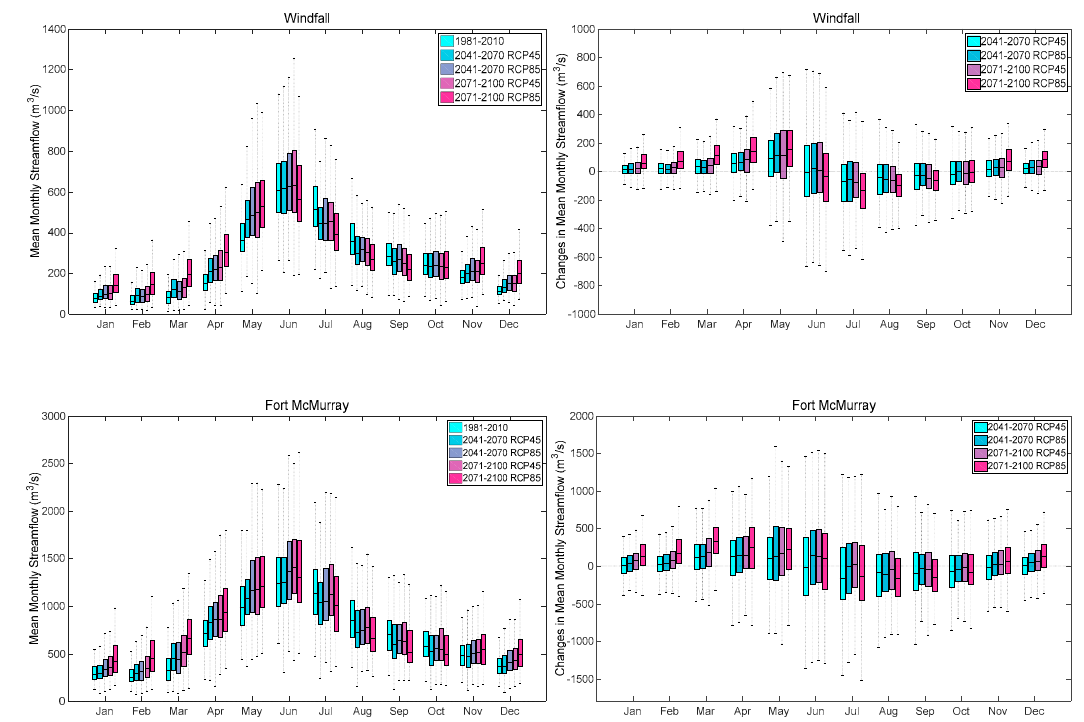
Figure 3. Box-and-Whisker plot of mean monthly streamflow projections and the corresponding changes between the baseline (1990s) and two future periods (2050s and 2080s) at two locations along the Athabasca River based on 12 sets of climate projections (six GCMs × 2 SD) and two RCPs (RCP4.5 and